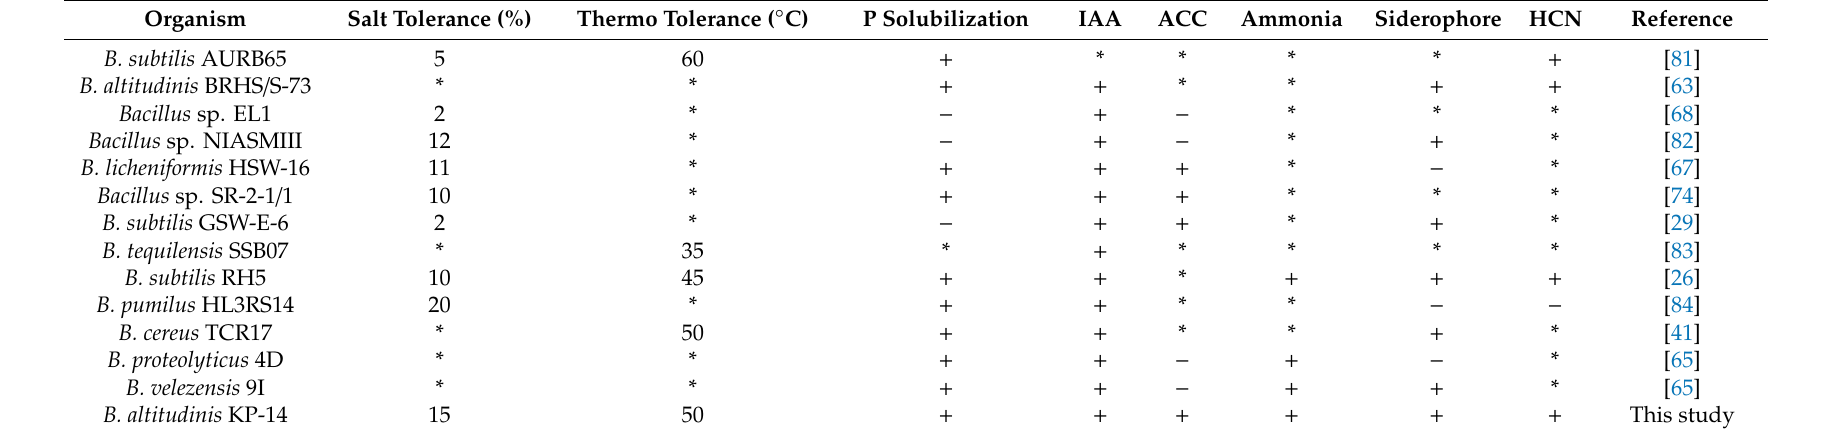
Table 5. PGP attributes and the abiotic stress tolerance exhibited by di ff erent Bacillus